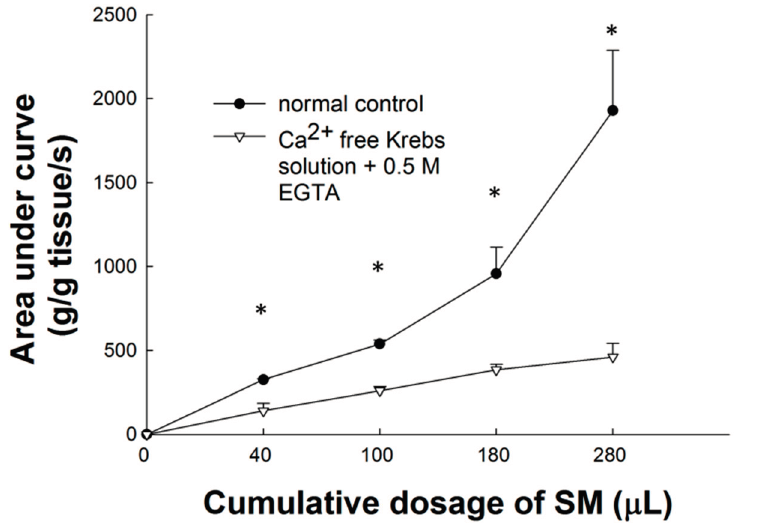
Figure 3. Effects of Ca 2+ -free Krebs-Henseleit solution with EGTA on contraction of